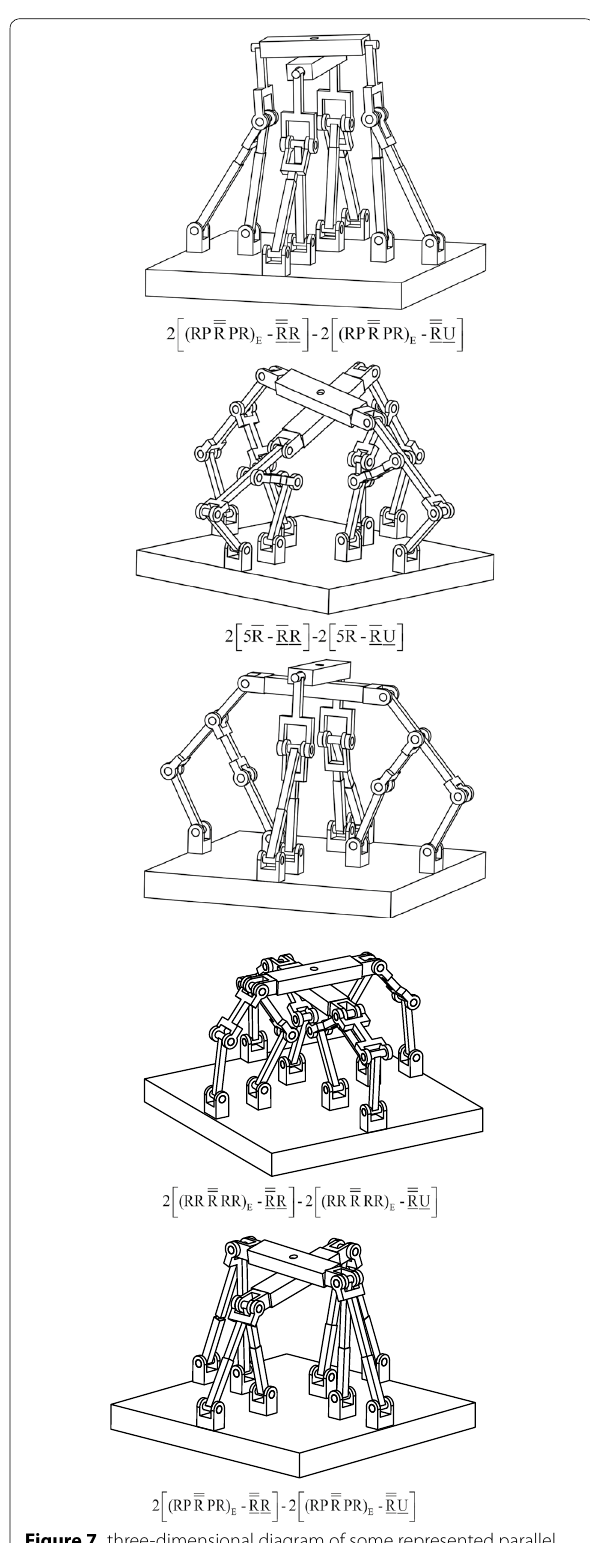
Figure 7 three-dimensional diagram of some represented parallel